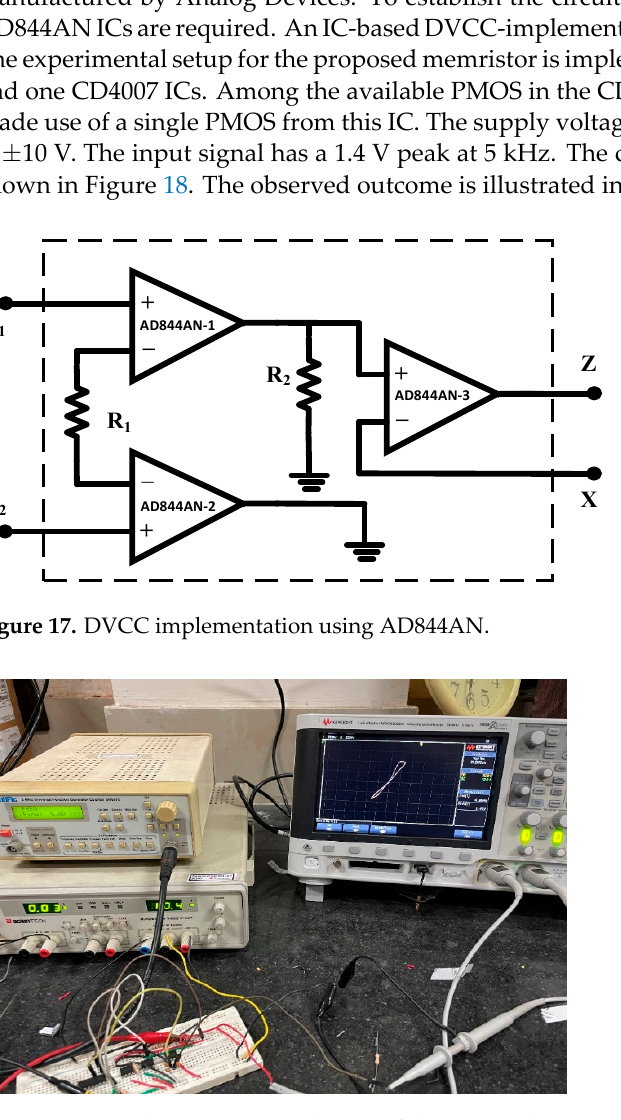
Figure 16. Memductance variation with input pulse for (a ) incremental configuration and ( b ) dec- remental configuration.